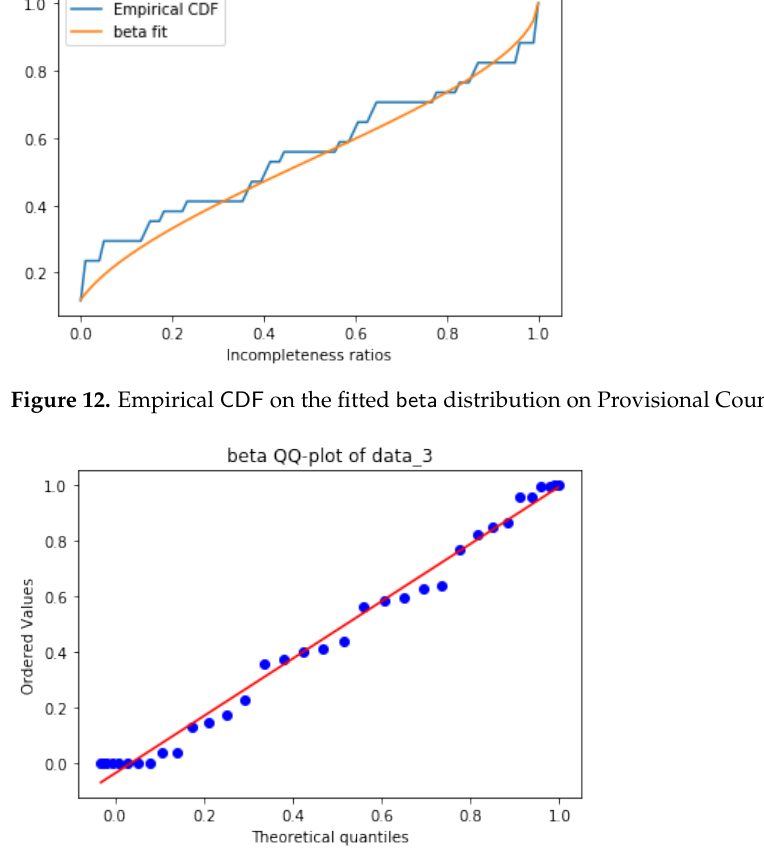
Figure 13. quantile – quantile plot for Provisional Counts of Death